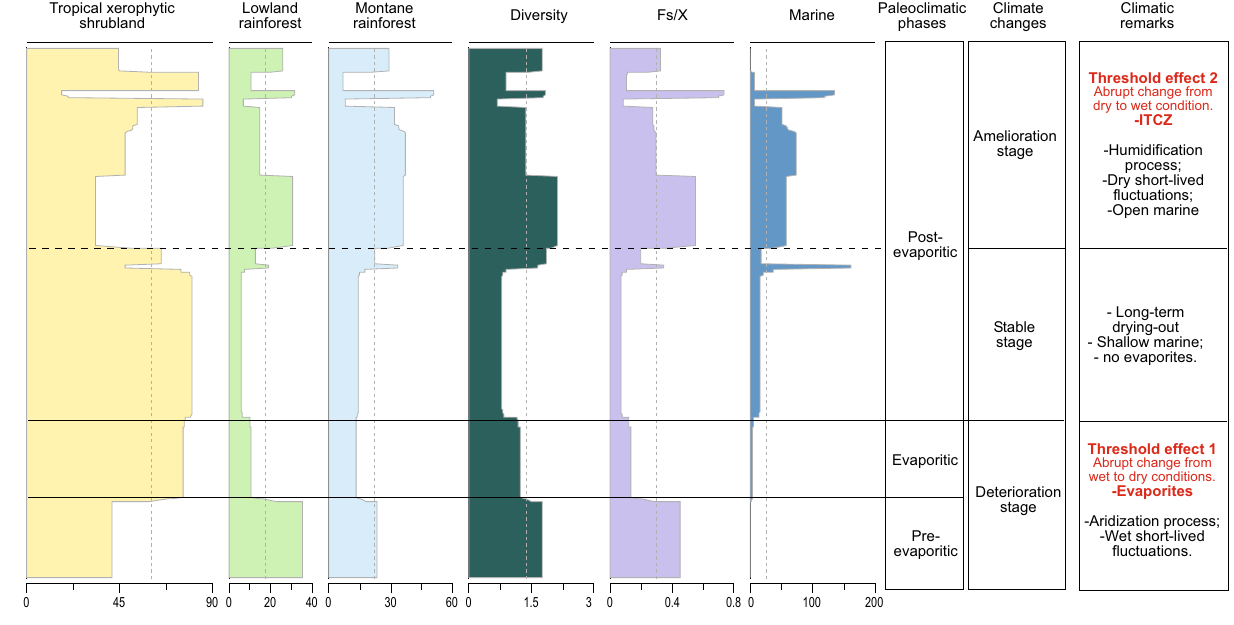
Figure 5. Biome trends in relation to paleoclimatic phases. Change in biomes, diversity, Fs/X ratio and marine elements shown by changepoint analysis plotted against paleoclimatic